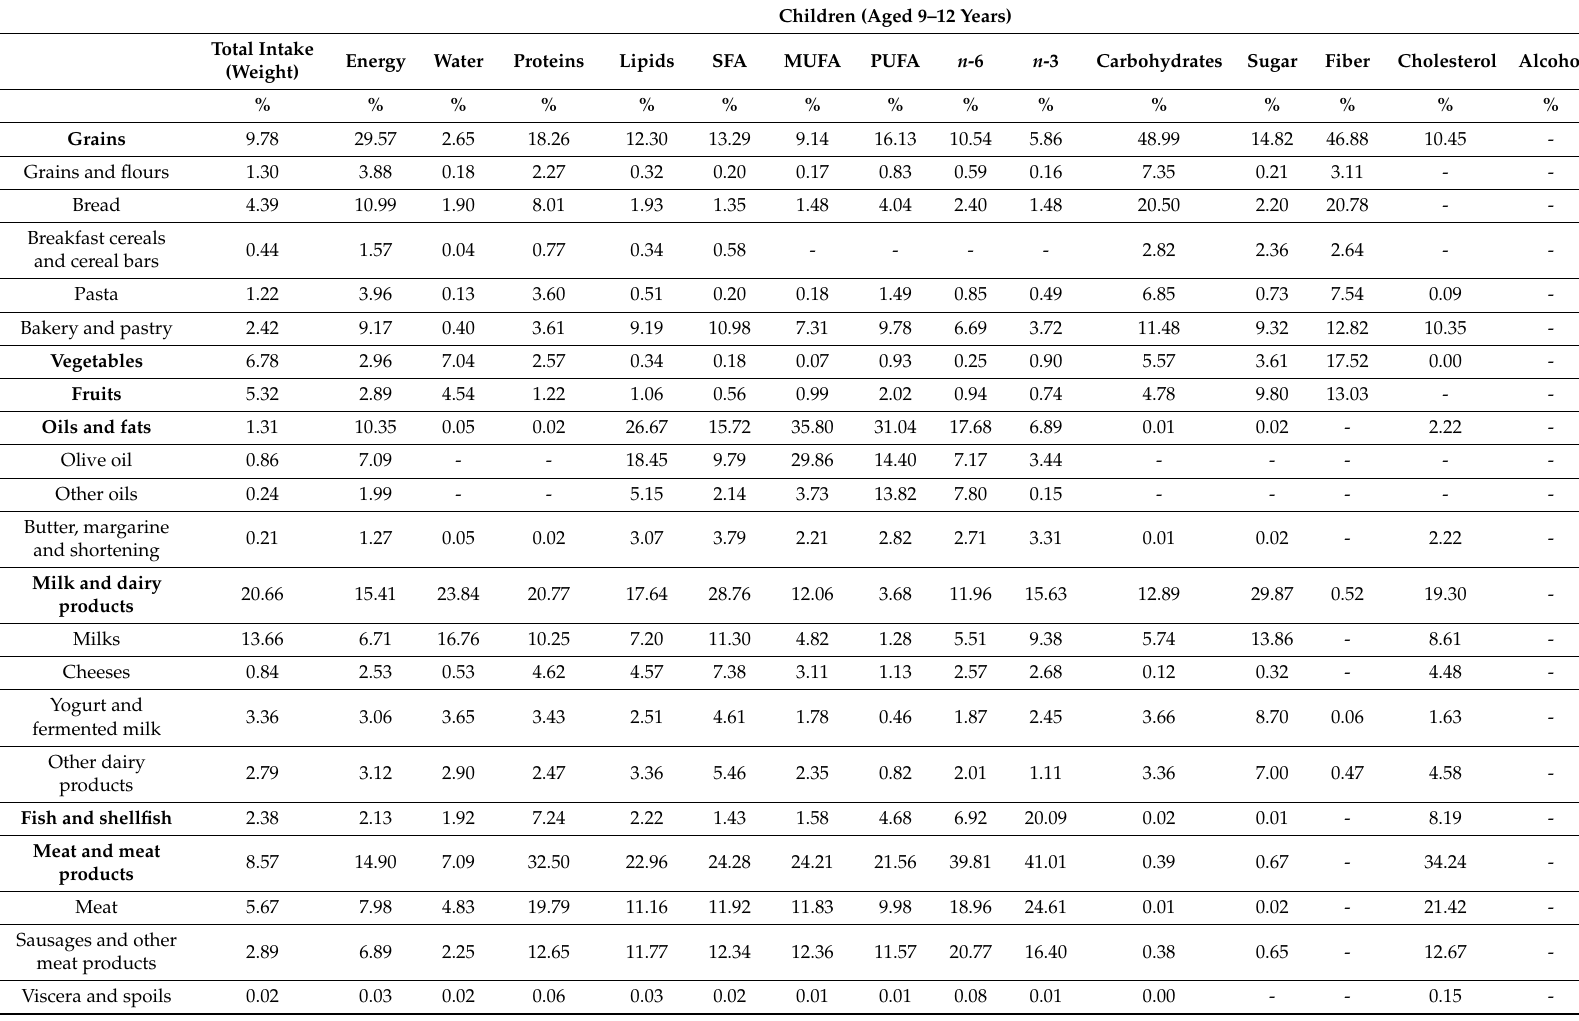
Table 4. Dietary sources of nutrients (%) from food groups/subgroups in the Spanish ANIBES study population: children aged 9–12 years ( n =